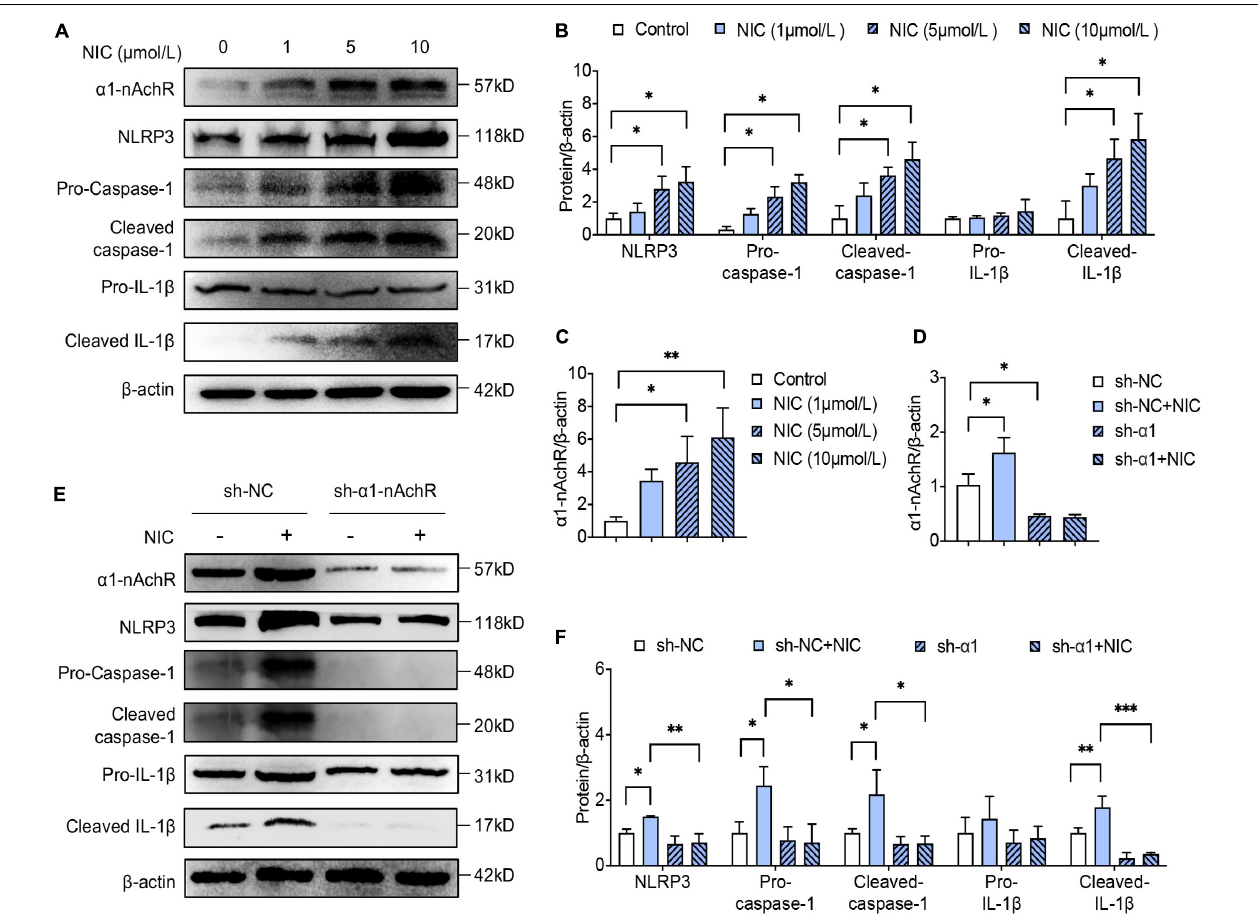
FIGURE 1 | α 1-nAchR was the specific receptor of nicotine in NLRP3 inflammasome activation of macrophage. (A–C) The protein expression and quantitative analysis of α 1-nAchR, NLRP3, and the cleavage of caspase-1 and IL-1 β in RAW264.7 cell lines treated with different concentrations of nicotine. (D–F) Lentivirus transfection was used to knock down α 1-nAchR in macrophage. The protein expression and quantitative analysis of α 1-nAchR, NLRP3, and the cleavage of caspase-1 and IL-1 β in sh- α 1nAchR transfected macrophage. All data are represented as mean ± SD of three independent experiments. ANOVA test followed by Holm–Šídák post-hoc test was used for statistical analysis. ∗ p < 0.05, ∗∗ p < 0.01, ∗∗∗ p < 0.001. NIC, nicotine; NLRP3, Nod-like receptor protein 3; sh-NC, short hairpin RNA of negative control; sh- α 1nAchR, short hairpin RNA of α